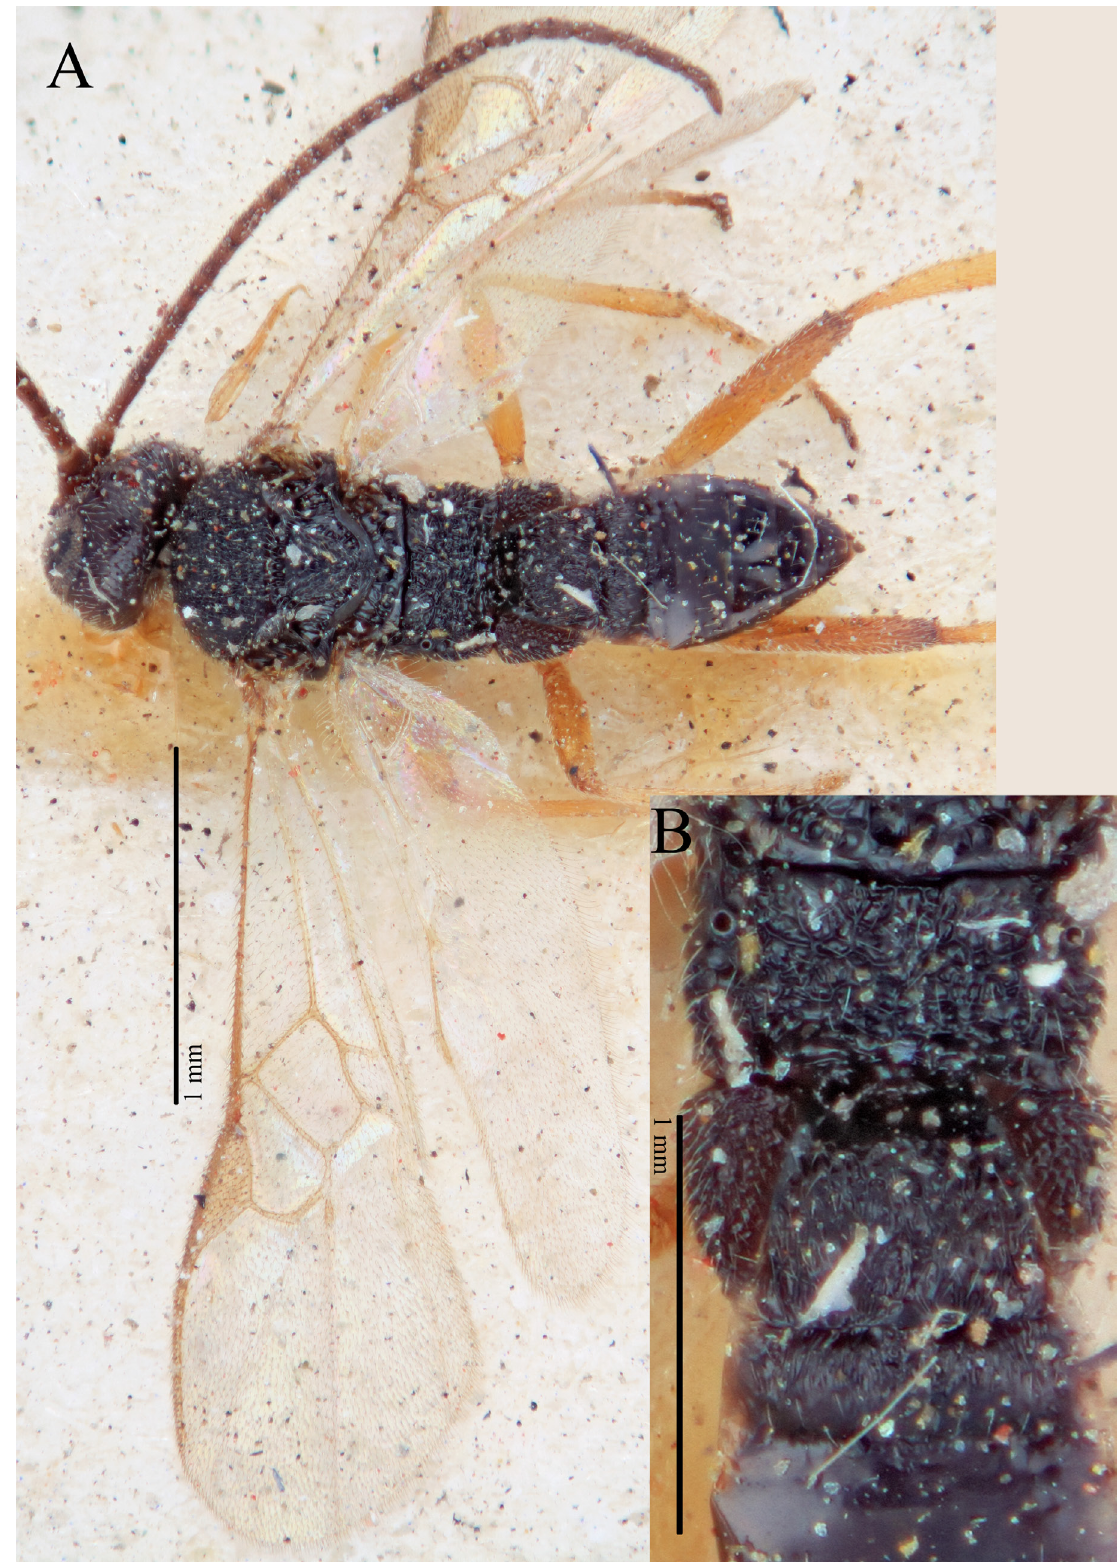
Fig. 26. Cotesia ruficrus (Haliday, 1834), syntype of C. sydneyensis (Cameron, 1911) (NHMUK 3.c.999). A . Habitus in dorsal view and fore wing B . Enlarged section of A showing propodeum and